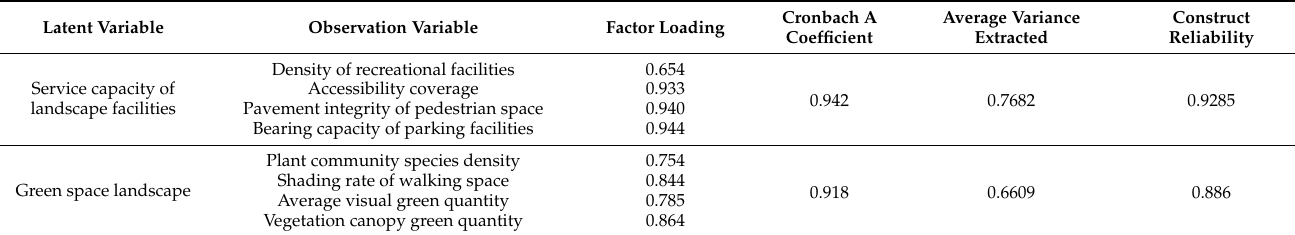
Table 3. Validity test of evaluation factors.